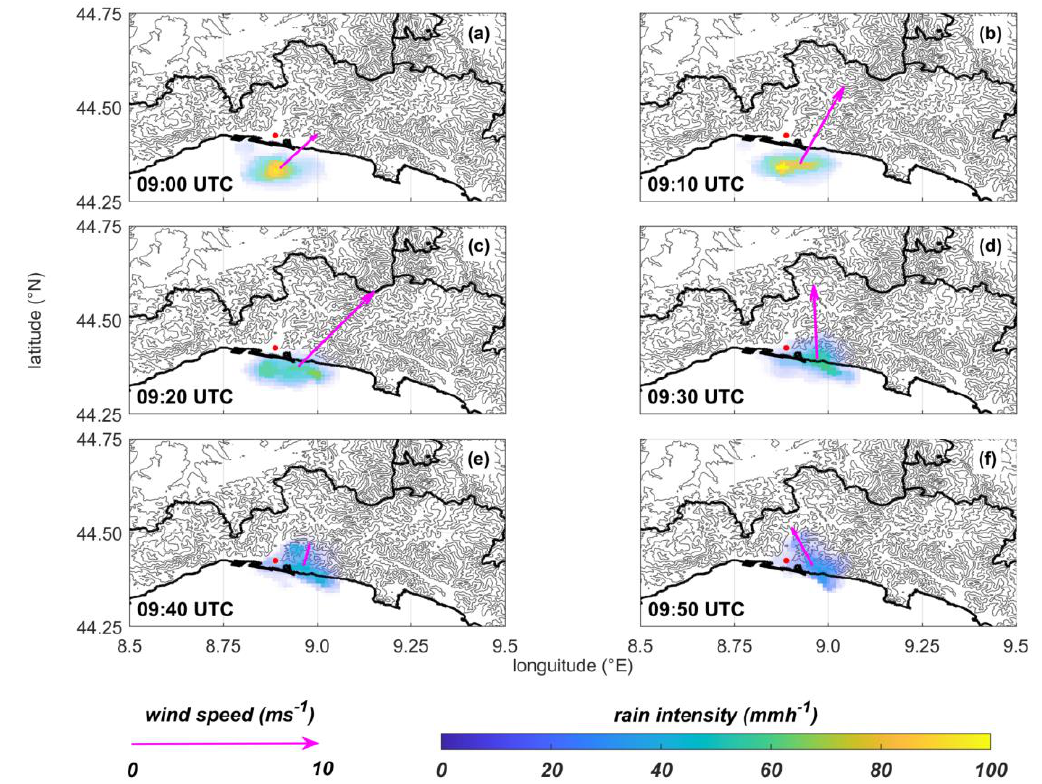
Figure 6. Rain cell observed offshore the Port of Genova on 4 August 2018 between 09:00 UTC (panel ( a )) and 09:50 UTC (panel ( f ))), every 10-min. The arrow is placed in the cell’s center of mass and its length is proportional to cell’s translational velocity. Observed 5-min mean intensities were as high as 100 mm h −1 .